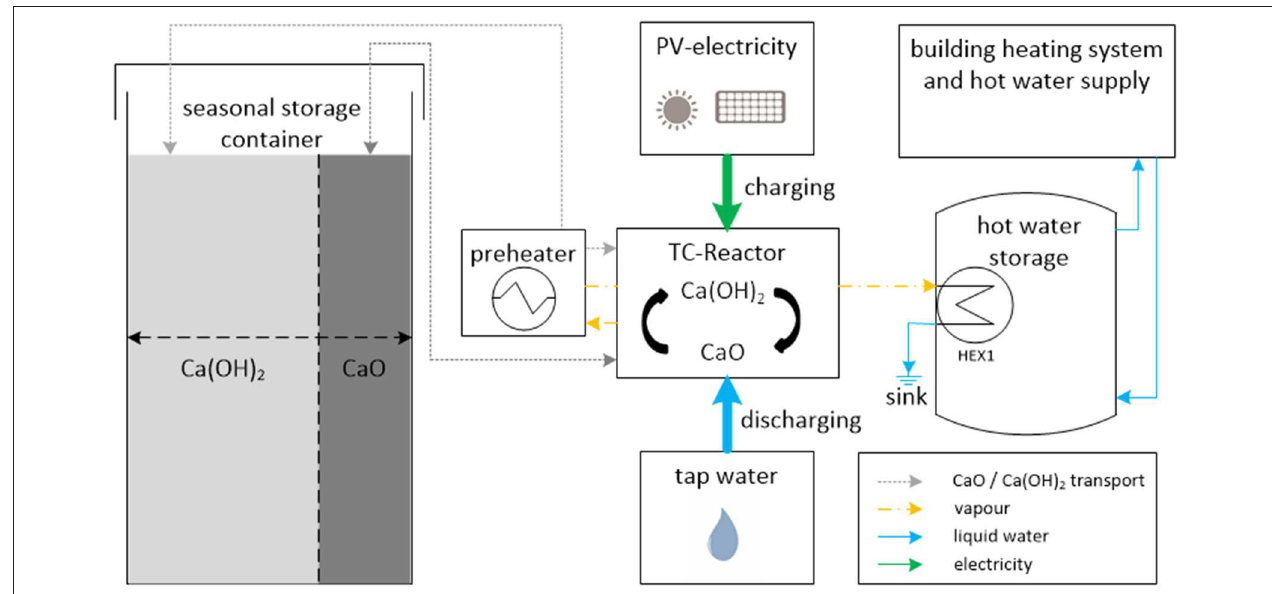
FIGURE 2 | Conceptual process design for a decentralized, seasonal thermochemical storage system based on the reaction material Calcium